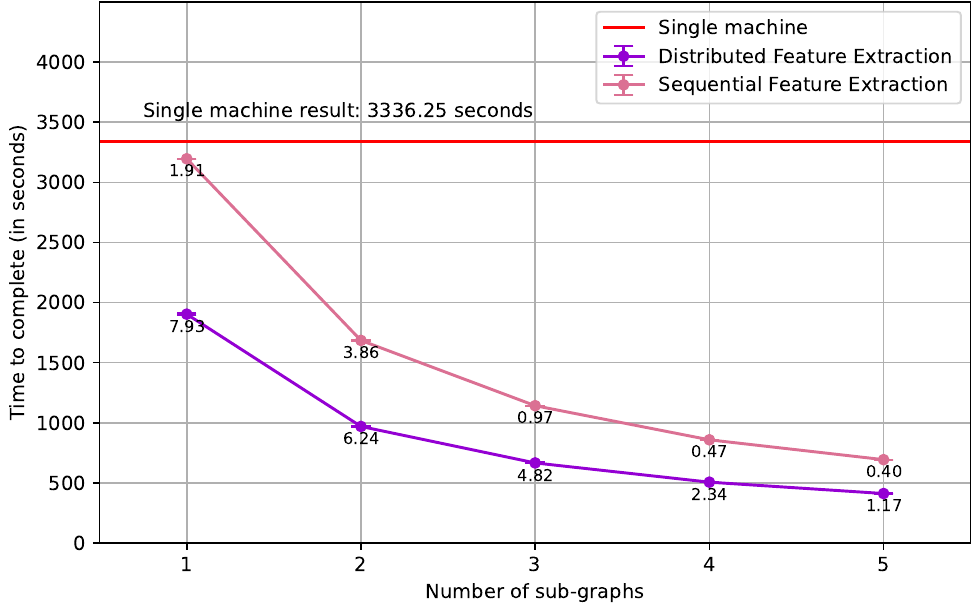
Figure 16. Results obtained from performing feature extraction with pre-trained VGG-16, DenseNet- 121, and ResNet-50 models, where the models are either distributed among three workers (Distributed Feature Extraction), or put in a sequence on a single worker (Sequential Feature Extraction). The im- ages have been processed with a batch size of 500. The standard deviation is shown as an error bar and value at each data